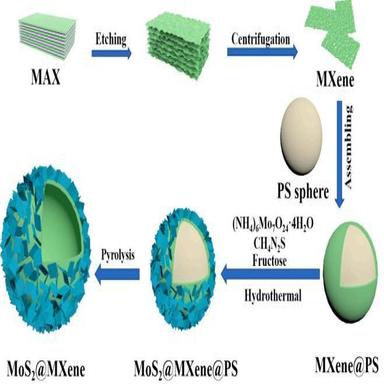
Schematic diagram of the hollow structure MoS2@MXene.